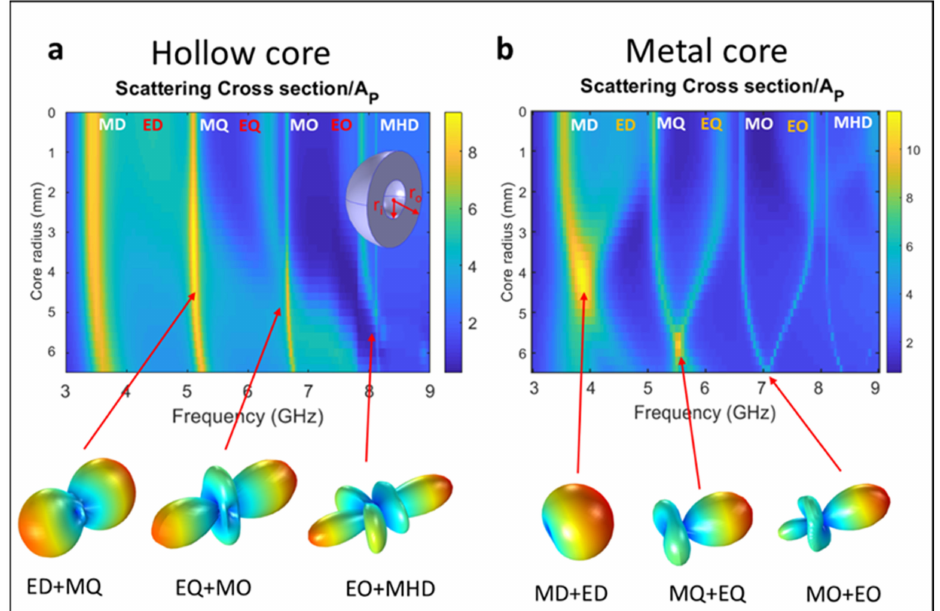
Figure 3. Showing the scattering cross section (normalized to the geometric cross section of the particles A P ) for a 12.5 mm radius dielectric sphere with a permittivity ε = 10.5 and a loss tangent δ = 0.001 with varying radius ( r i ) of ( a ) air-filled/hollow and ( b ) metallic core. The inset shows a cross section of the geometry. Each design shows three overlap points between different modes, and the 3D farfield scattering pattern for each combination is shown